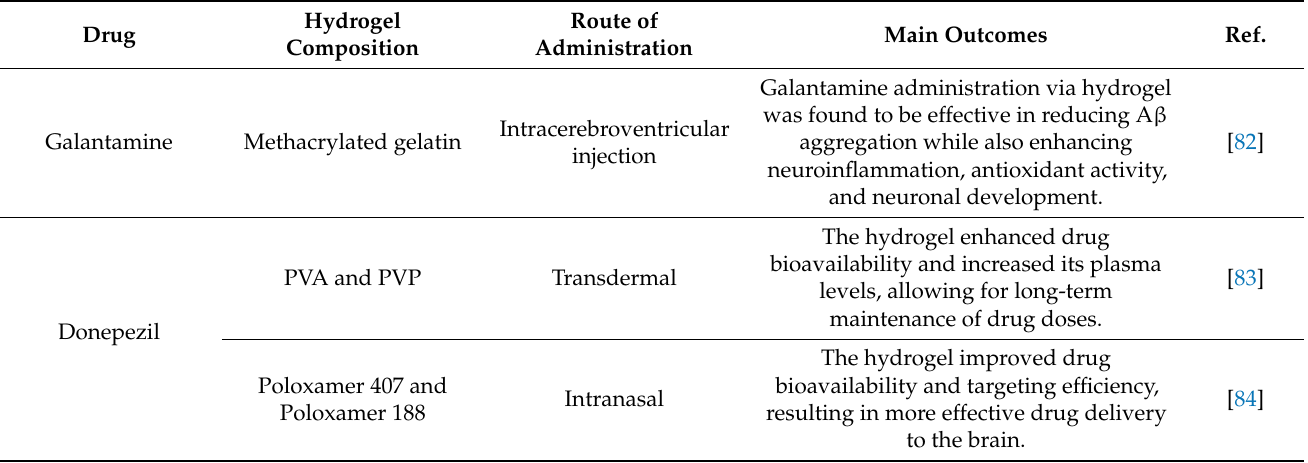
Table 2. The most recent applications of hydrogels as DDSs for delivering FDA-approved Alzheimer’s